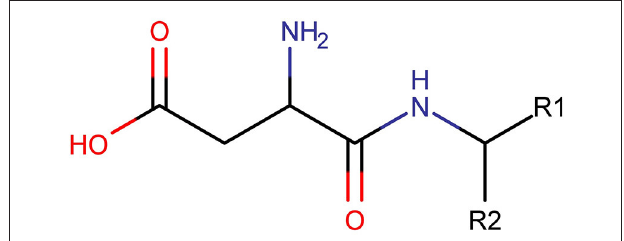
FIGURE 2 | Common chemical scaffold of sweeteners grouped in cluster S1.